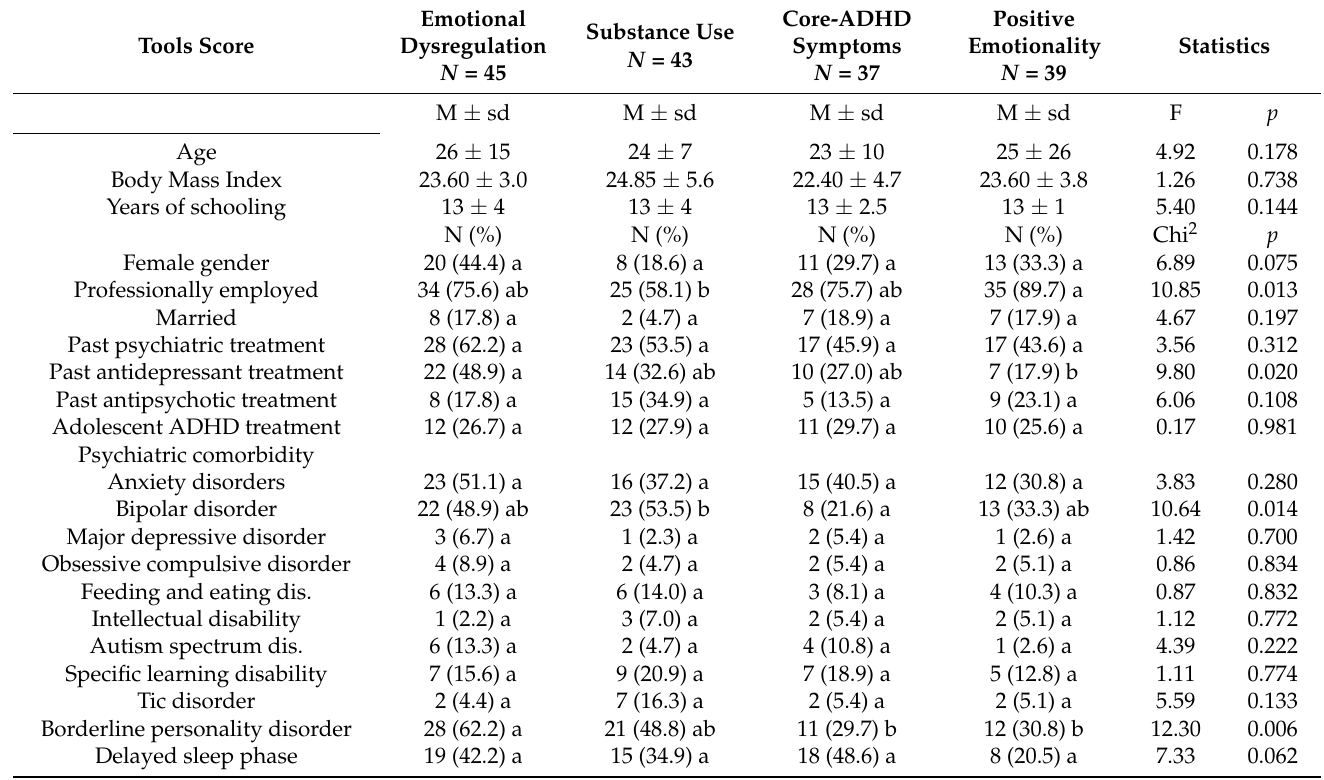
Table 2. Demographic and clinical characteristics, comparisons between dominant